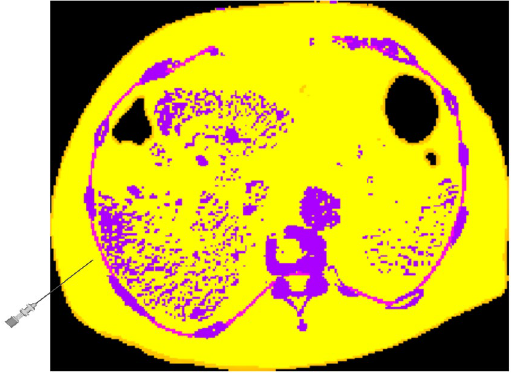
Figure 11. Color coded application of Fig. 10 to an undeformed axial CT slice just before puncturing the fascia.